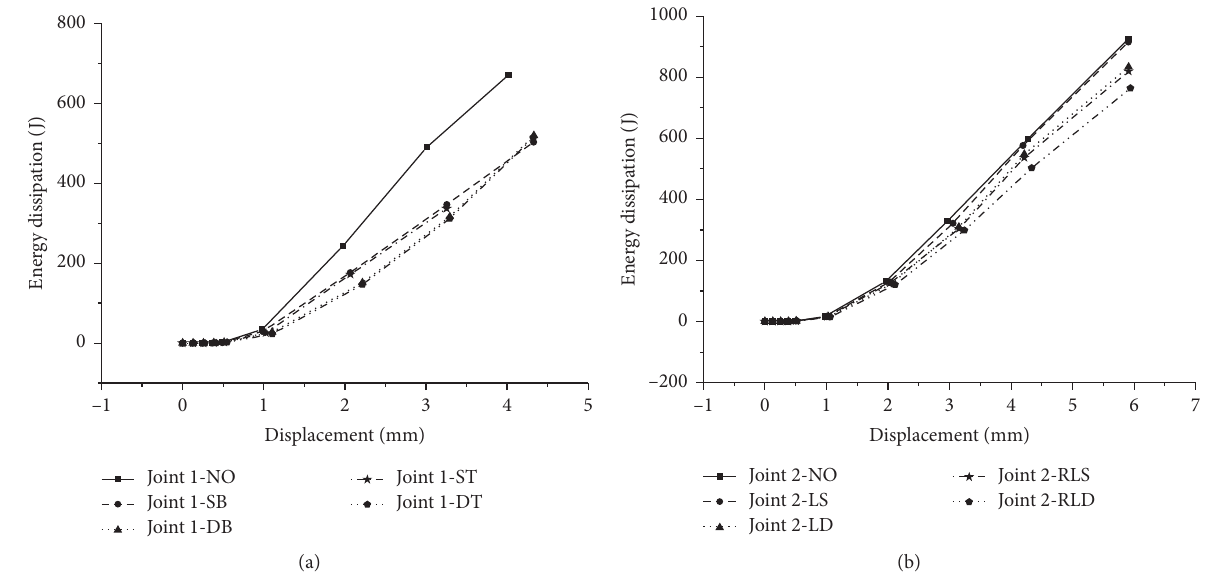
Figure 20: Comparisons of energy dissipation curves: (a) Joint 1; (b) Joint 2.